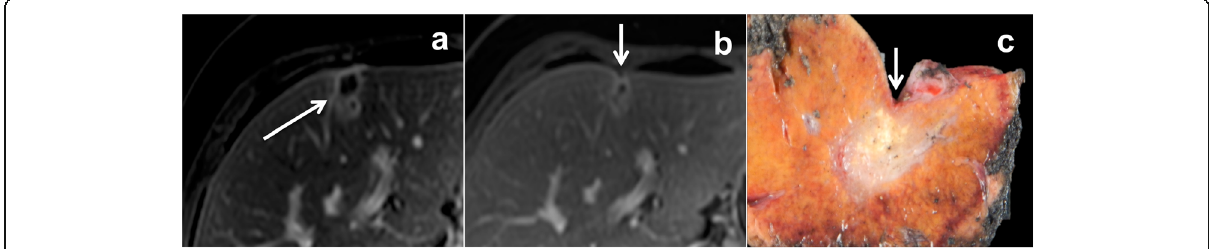
Fig. 11 Example of preoperative chemotherapy-induced fibrosis in a 64-year-old male patient with non-otherwise specified (NOS) adenocarcinoma of the colon. Contrast-enhanced fat-saturated gradient recall echo T1-weighted images on delayed phase images before ( a ) and after ( b ) treatment. Before treatment, the liver metastasis (arrow) shows progressive peripheral enhancement consistent with the presence of fibrous stroma. After treatment, a shrinkage of the lesion and the appearance of a focal capsular retraction (arrow) is observed. The pathological